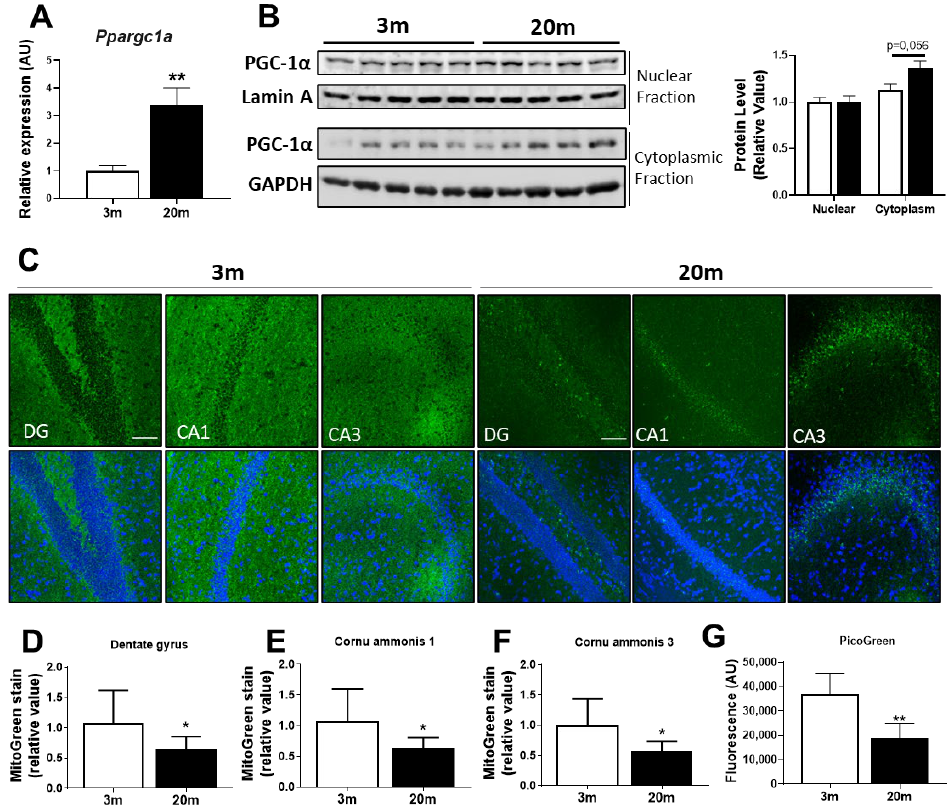
Figure 5. Mitochondrial biogenesis parameters in the hippocampus of female 3 mo and 20 mo C57BL/6J mice . ( A ) Relative mRNA expression of peroxisome-proliferator-activated receptor gamma co-activator ( Ppargc1a ) of the hippocampus. ( B ) Western blot and densitometric analysis of PGC- 1α levels in a nuclear fraction and a cytoplasmatic fraction. ( C ) Representative images of non- fixed hippocampal slices stained with the mitochondrial fluorescent dye MitoTracker Green FM (MitoGreen) as a measurement of mitochondrial mass. The scale bar corresponds to 100 µm. ( D – F ) Quantitative analysis of fluorescence intensity was performed in the DG, CA1, and CA3 regions of the hippocampus (20×). ( G ) PicoGreen dsDNA quantitation assay in an isolated mitochondrial enriched fraction. Densitometric analysis is expressed as levels relative to control. Graph bars represent means ± SEM. * p < 0.05; ** p <